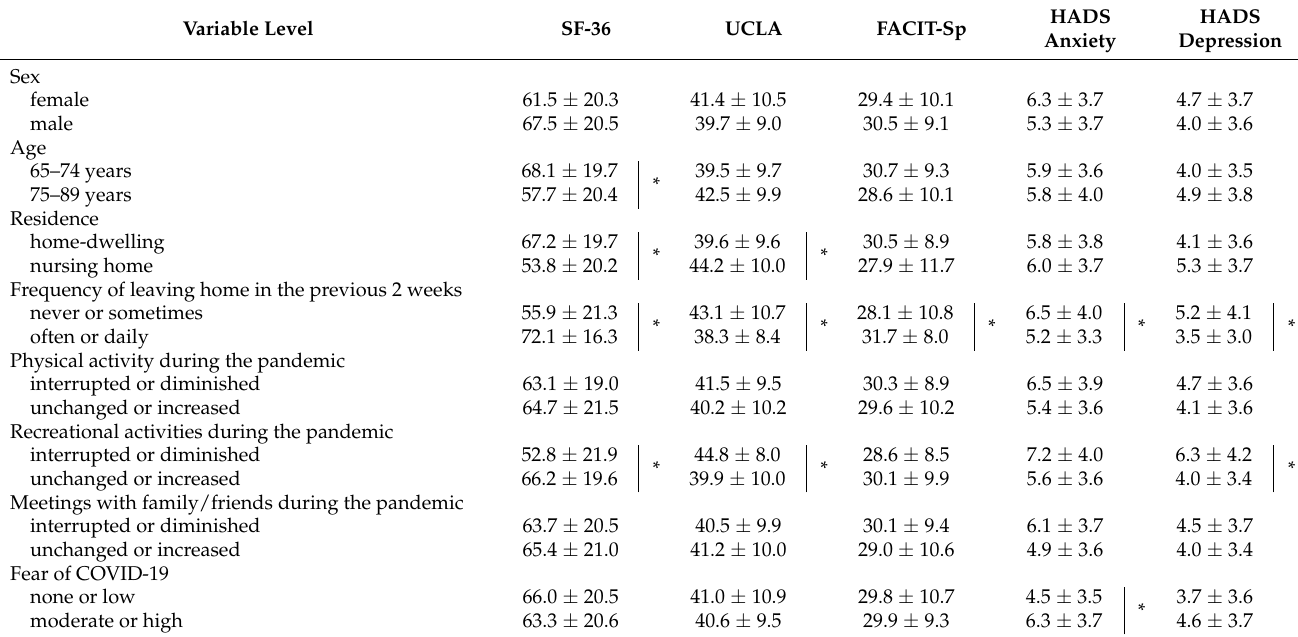
Table 2. Mean and standard deviation scores of the questionnaires employed in the study by function of the main study variables. * Asterisks denote a significant difference ( p < 0.01 obtained after Bonferroni correction for multiple comparisons across the five questionnaires) in the questionnaire means obtained from the two levels of each study variable.